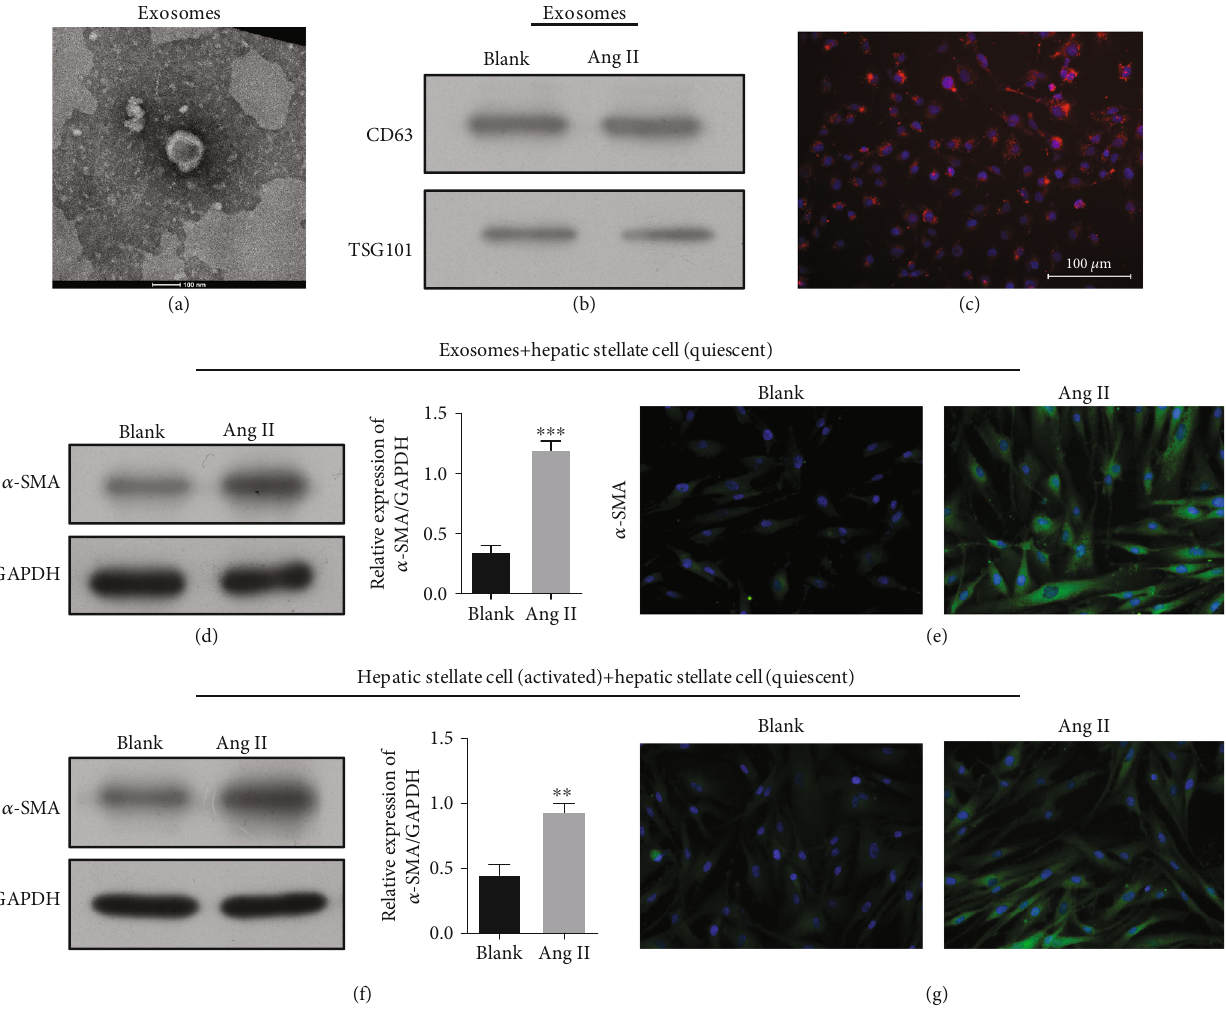
Figure 3: ERS caused exosome release from activated HSC cells. Exosomes released by LX-2 cells in the Ang II and blank groups were detected by electron microscopy (a). (b) Western blot analysis of α -SMA expression in exosomes released by LX-2 cells in the Ang II and blank groups. PKH-26-labeled exosomes (red) were taken up by LX-2 cells (c). Scale bar, 100 nm. Western blotting (d) and immuno fl uorescence staining (e) of α -SMA in quiescent HSC cells after incubated with exosomes released from activated HSC cells. Western blotting (f) and immuno fl uoresce nce staining (g) of α -SMA in quiescent HSC cells cocultured with activated HSCs. ∗∗ p < 0 : 01 and ∗∗∗ p < 0 : 001 vs.